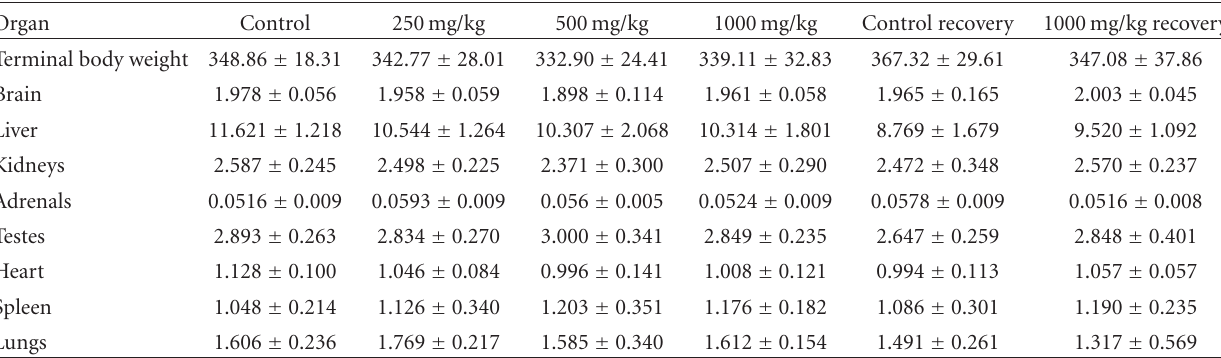
Table 6: Absolute organ weights (g; mean ± SD) in male rats after 90 days subchronic oral administration of Zigbir (cid:2) . Organ